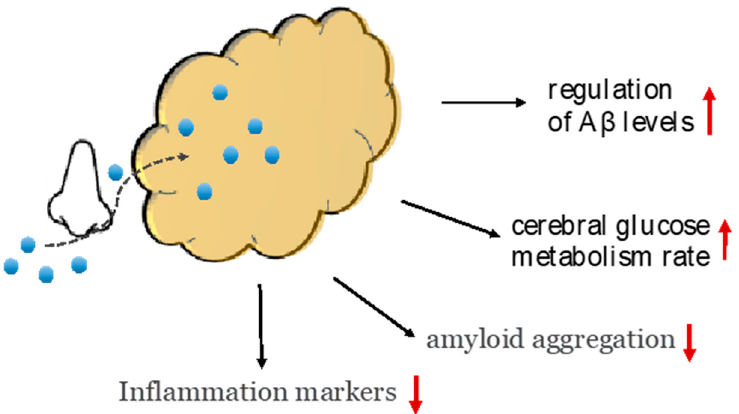
Figure 4. Intranasal insulin administration therapeutic evidence is based on several mechanism such as the reduction in β amyloid and general inflammation marker. Intranasal insulin bypasses the blood–brain barrier, which leads to the regulation of A β levels and cerebral glucose metabolism